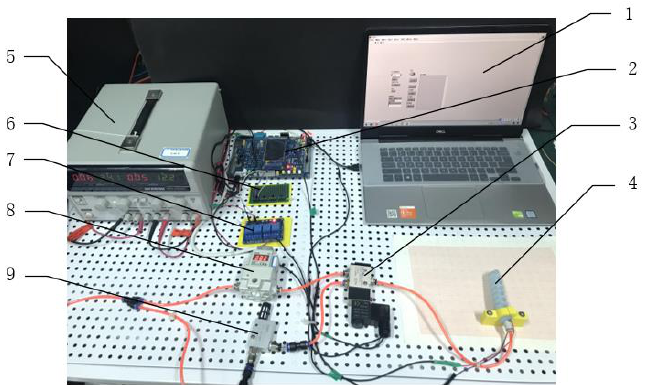
Figure 14. Experimental platform. 1. Host computer; 2. Stm32 MCU; 3. Solenoid valve; 4. Soft actuator; 5. DC power supply; 6. Triode amplifier circuit; 7. Relay module; 8. Proportional valve; 9. Vacuum generator.